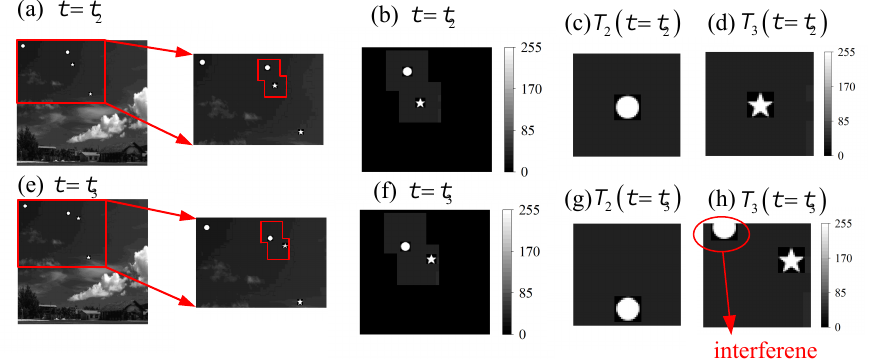
Figure 8. Illustrations of the windowed image at moment t 2 and t 3 : ( a – d ) represent the images at moment t 2 , and ( e – h ) represent the images at moment t 3 , ( c , g ) are the images of target T 2 , and ( d , h ) are the images of target T 3 . ( h ) contains the interference caused by target T 2 .